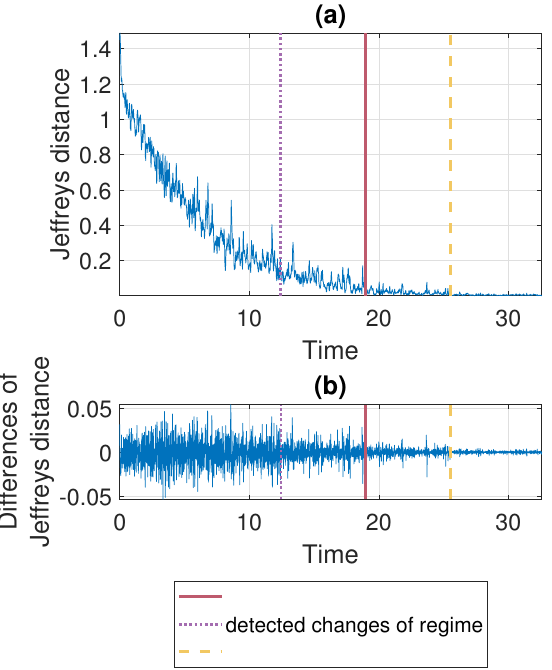
Figure 7. Jeffreys distance (panel ( a )) and differences of Jeffreys distance (panel ( b )) comparing the pdfs in the moving window of length 2500 with step equal to 250 to the pdf corresponding to the last window for Signal 1. Detected regime change points are marked in purple (dotted line), red (solid line), and yellow (dashed line).